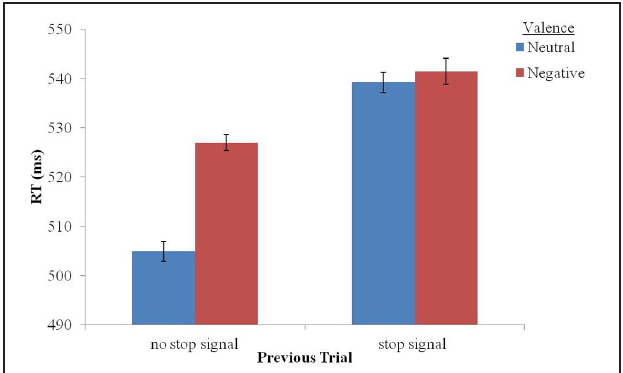
FIGURE 2 | Mean RT in the valence conditions following stop-signal trials or no stop-signal trials. Error bars represent one standard error from the mean based on Cousineau’s (2005) method for within-subjects designs.